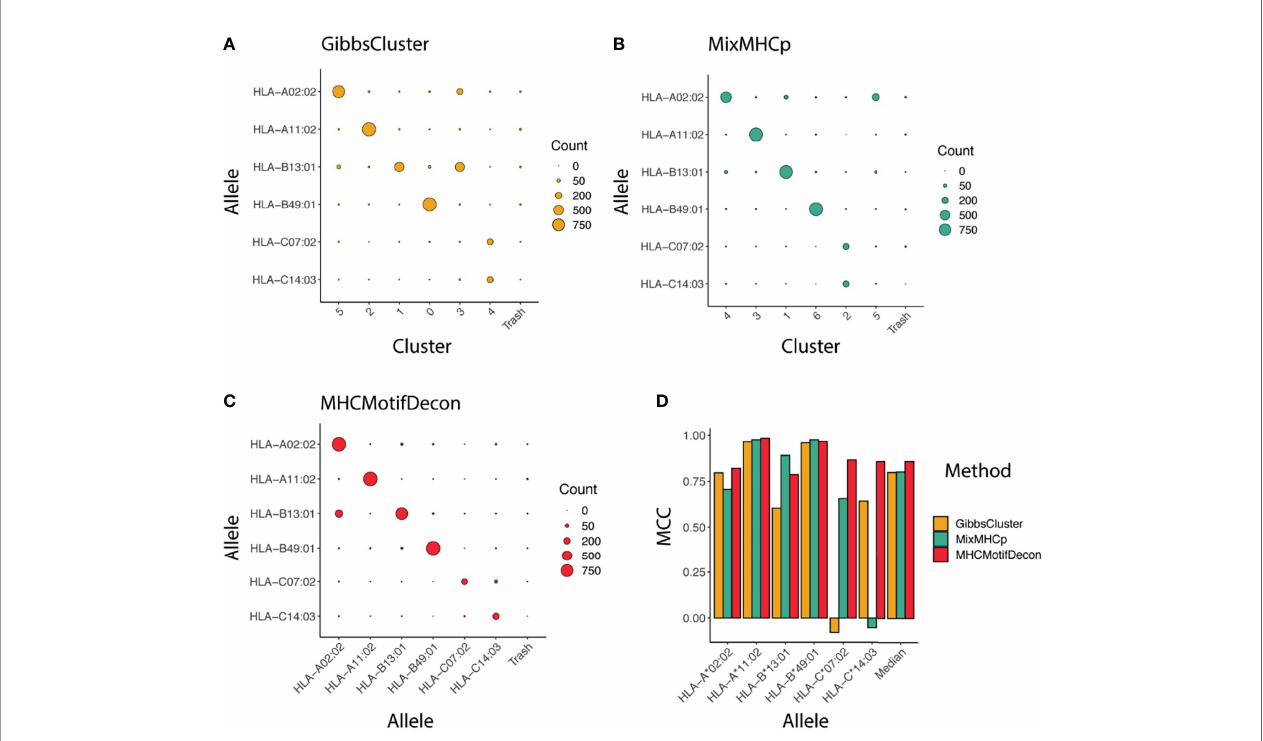
FIGURE 2 | Clustering confusion matrix and Matthews correlation performance for the three methods (A) GibbsCluster, (B) MixMHCp and (C) MHCMotifDecon. (D) Matthews correlation (MCC) performance estimates of accuracy of the motif deconvolution of the different methods for the arti fi cial MS HLA eluted ligand dataset. MCC values for each method and HLA were estimated from the confusion matrices and cluster-HLA annotations shown in Figure 1 .